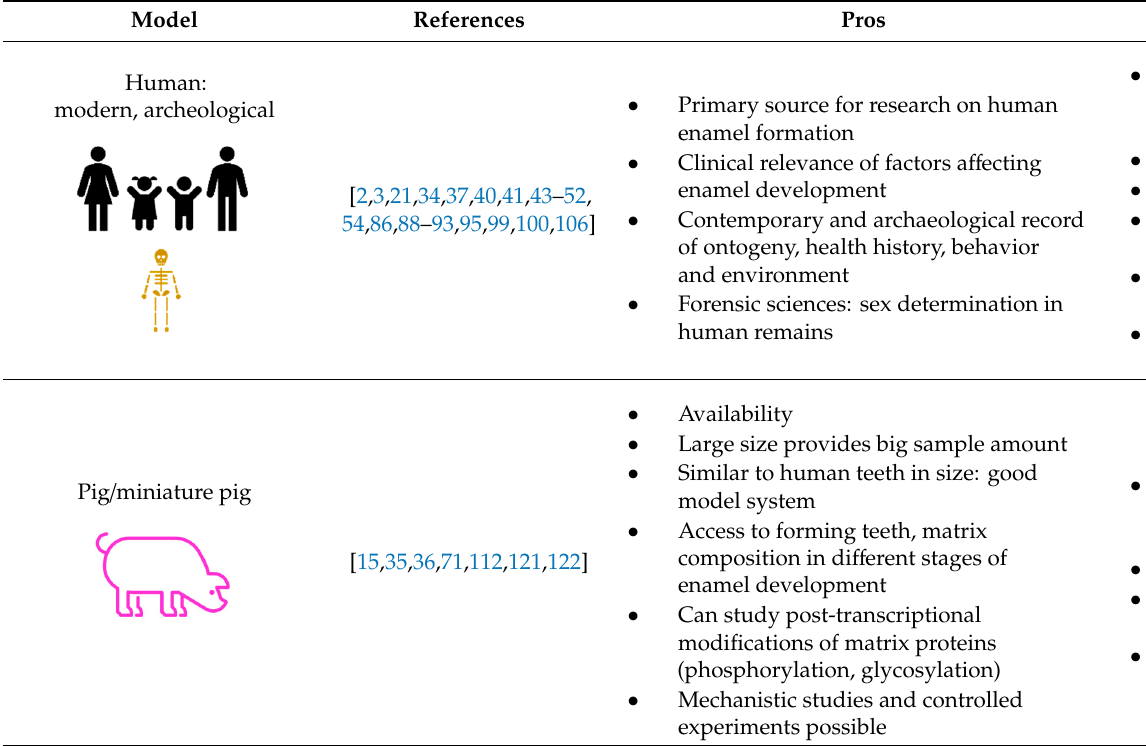
Table 3. Summary of pros and cons of the species for research on tooth enamel. Per model, the most prominent pros and cons on the models covered in this review are listed.